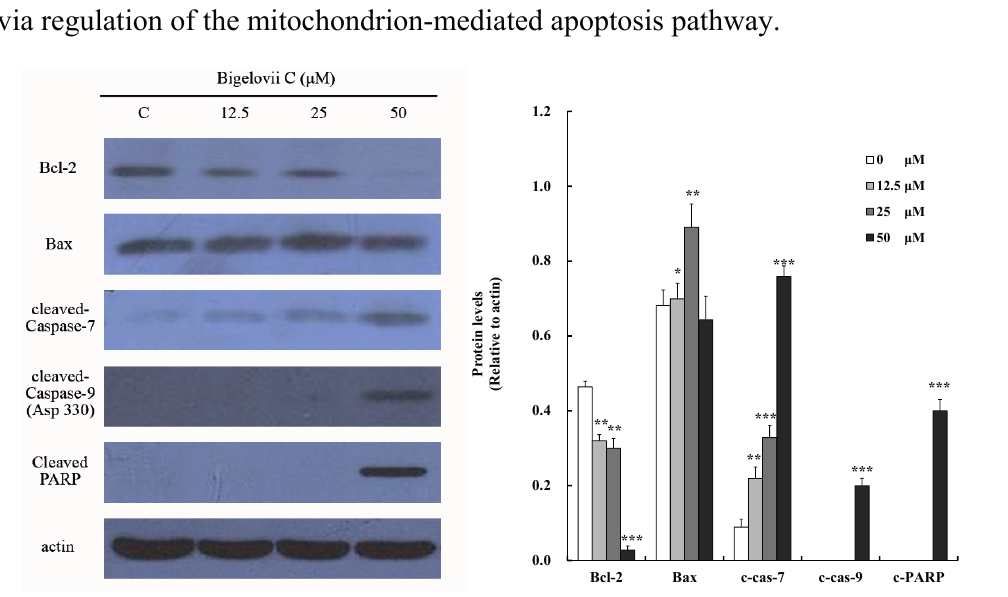
Figure 5. Effects of bigelovii C on the expression of cleaved caspase-7, cleaved caspase-9, cleaved PARP, Bcl-2 and Bax in MCF7 cells. * p < 0.05, ** p < 0.01 and *** p < 0.001, compared with the control